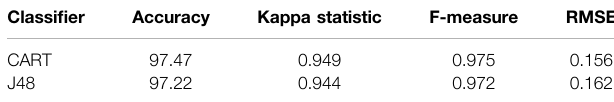
TABLE 3 | Classi fi ers ’ evaluation metrics.